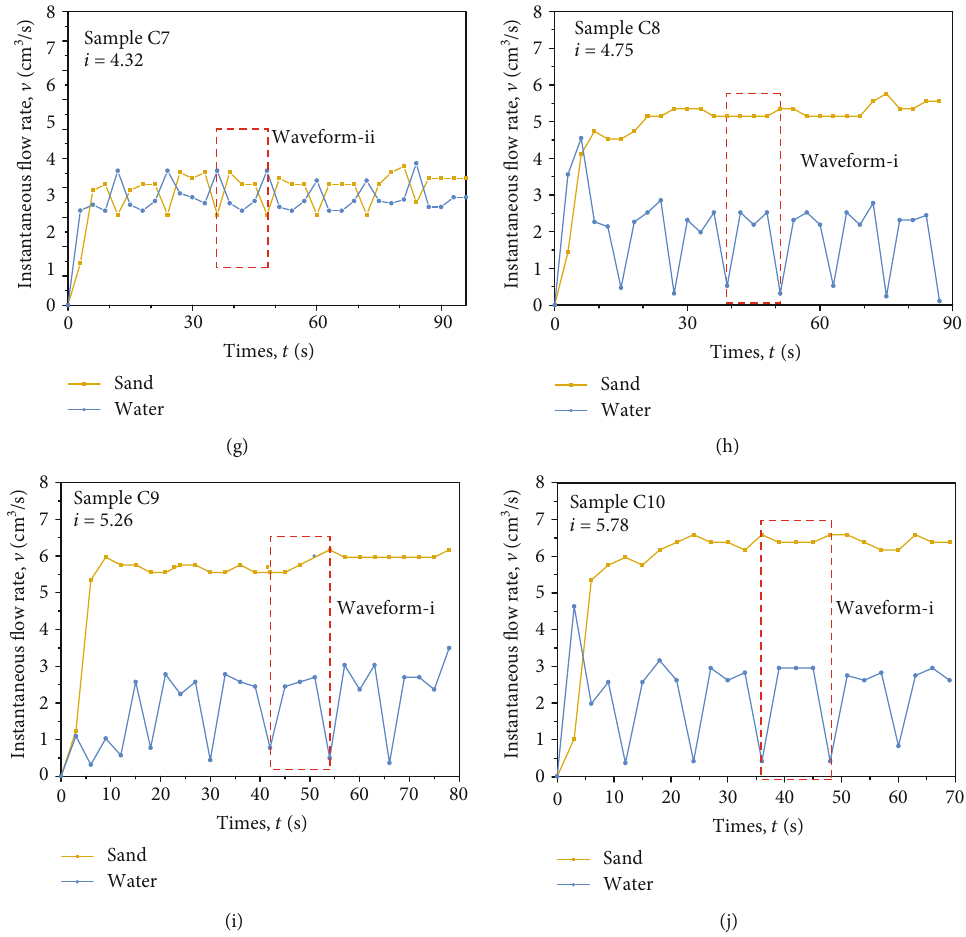
Figure 14: The variations of water and sand fl ow rates with time for di ff erent